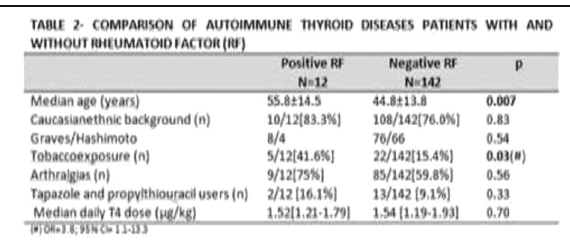
Table 2 (abstract P393). COMPARISON OF AUTOIMMUNE THYROID DISEASES PATIENTS WITH AND WITHOUT RHEUMATOID FACTOR (RF)